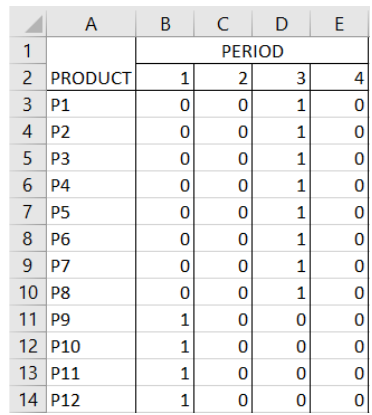
Figure 3. An example of production schedule ( y ) output format in